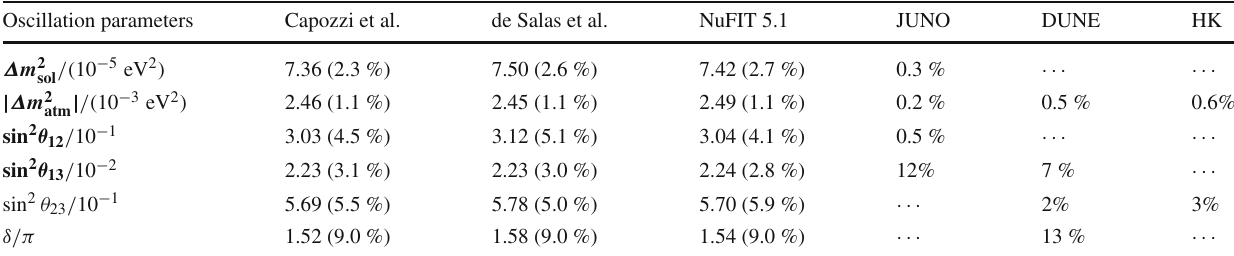
Table 1 The global fits and the prospects of neutrino oscillations parameters for IO. The first three columns summarize the results of three global-fit groups in the form of “best fit (1 σ precision in %)”